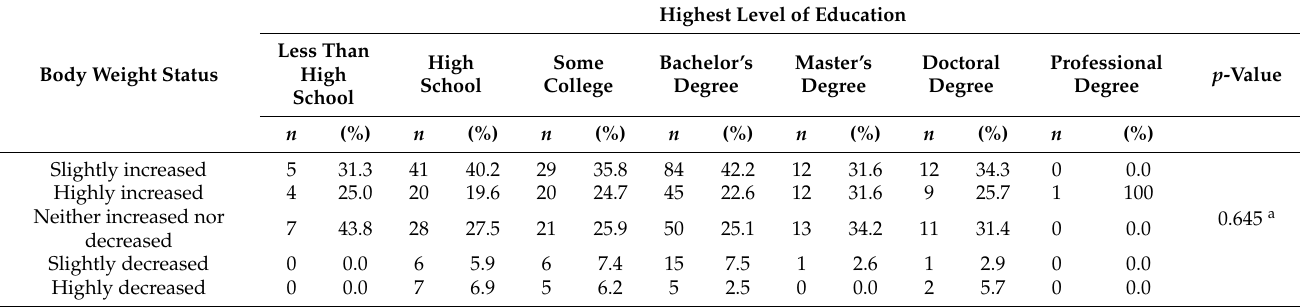
Table 6. Association of the body weight status and the highest level of education during the full COVID-19 pandemic curfew period.